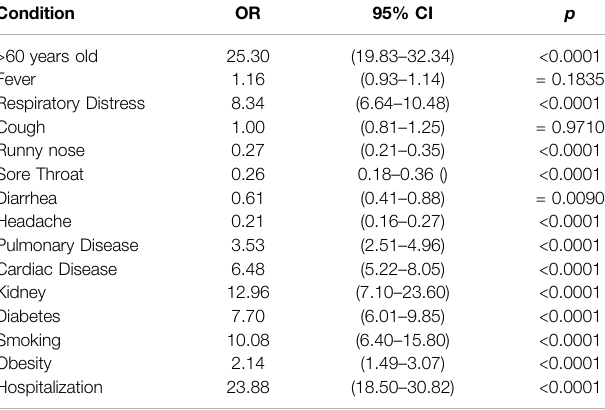
TABLE 7 | Odds ratio for training dataset.